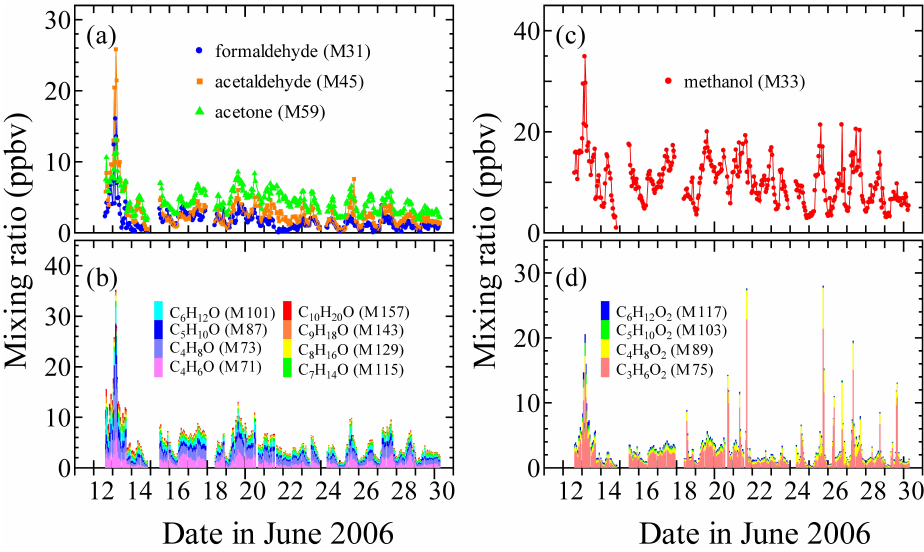
Fig. 5. Temporal variations of mixing ratios for OVOCs: (a) and (b) ketones/aldehydes, (c) methanol, and (d) C n H 2 n O 2 (acids/formates/acetates/hydroxyketones/hydroxyaldehydes). Hourly averaged PTR-MS data are